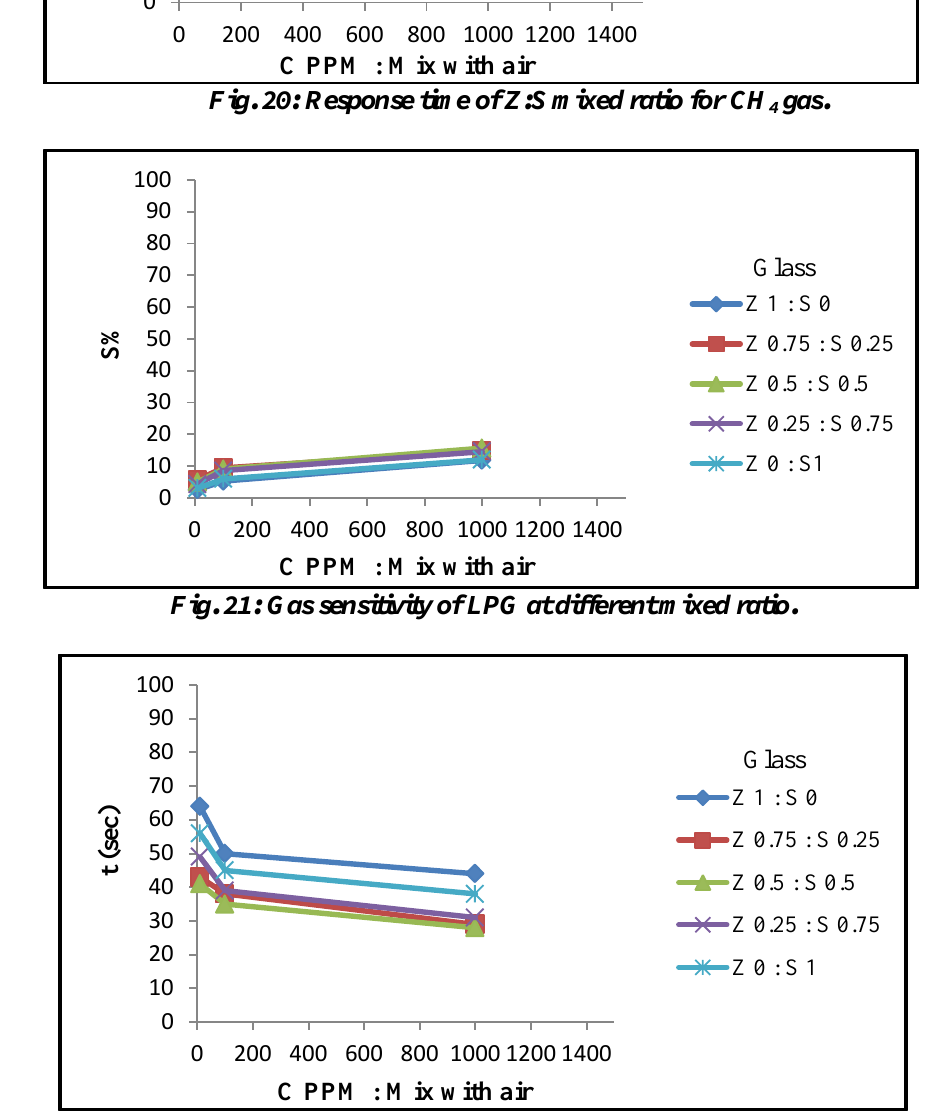
Fig. 22: Response time of Z:S mixed ratio for LPG